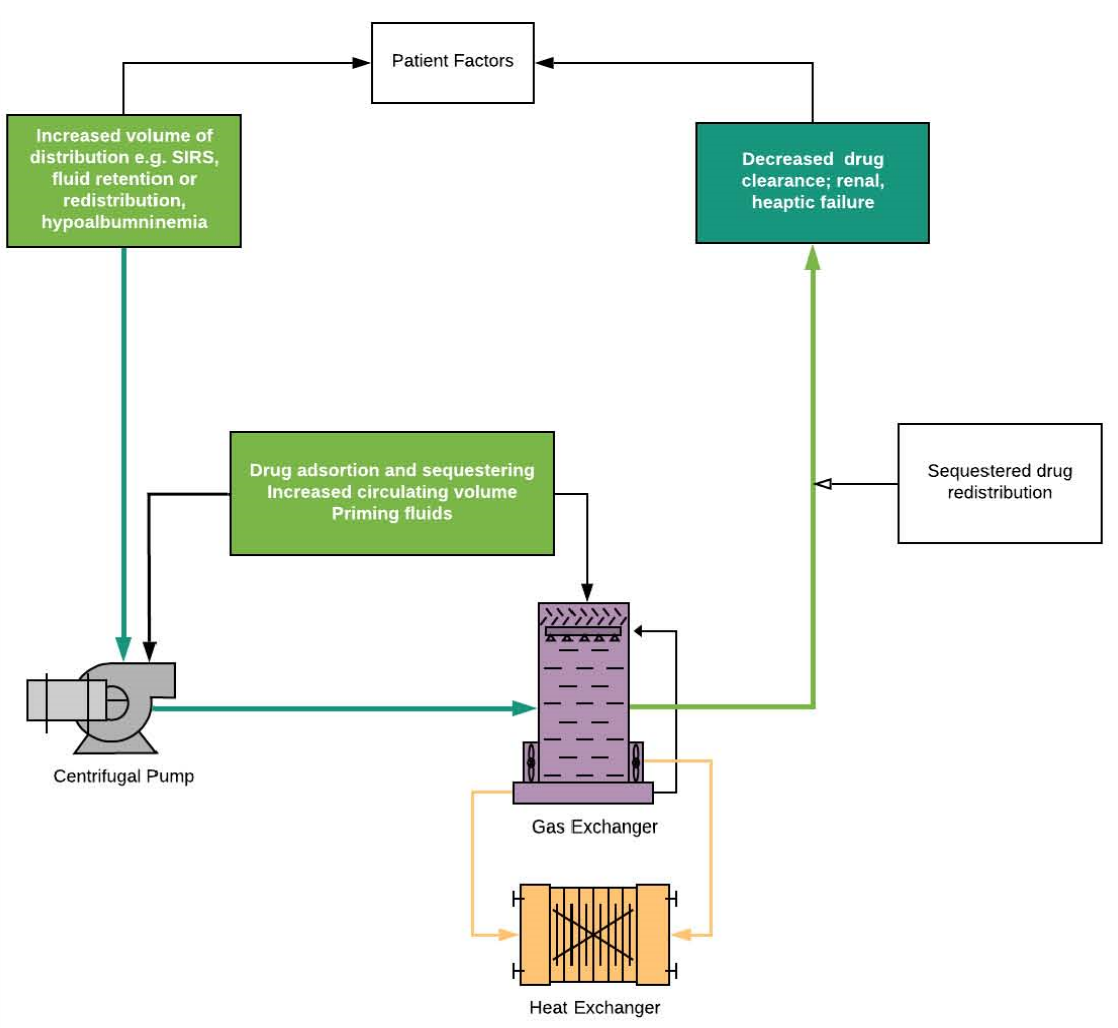
Figure 3. ECMO ‐ specific factor affecting drug distribution. Figure 3. ECMO-specific factor affecting drug